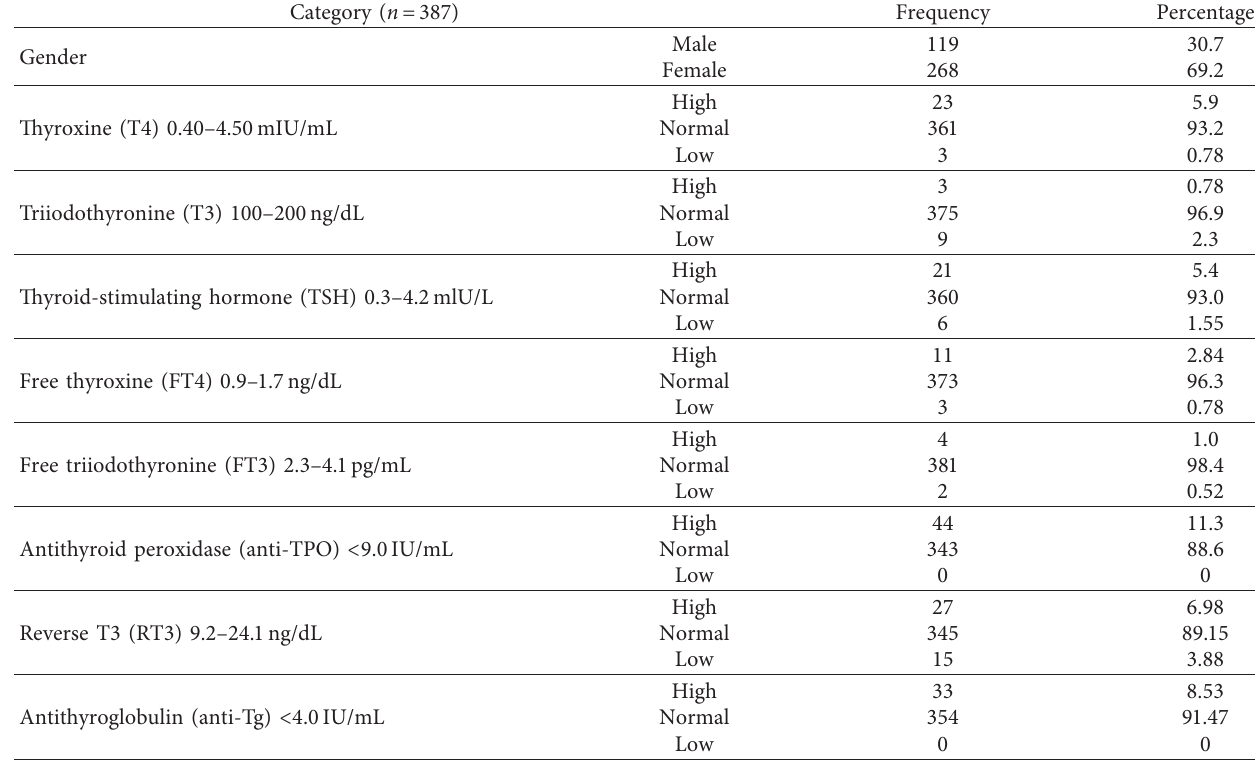
Table 1: General characteristics of candidates involved in the